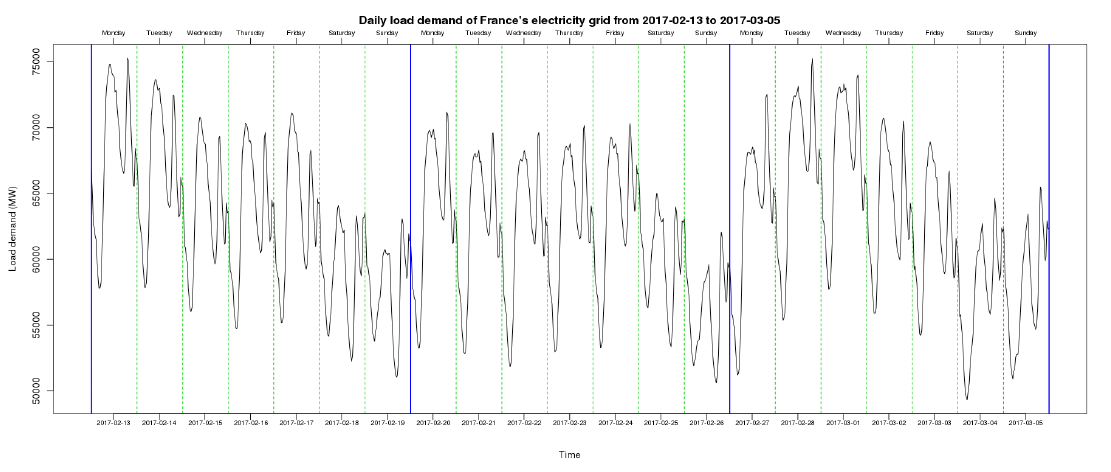
Figure 9. Daily load demand for France’s electricity grid from 13 February 2017 to 5 March